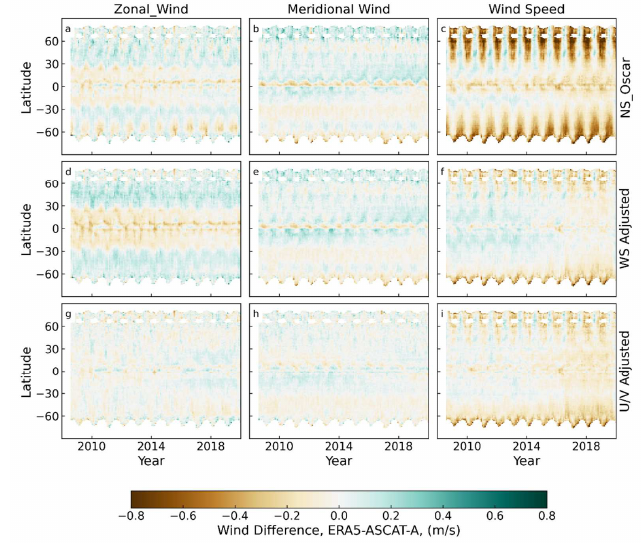
Figure A2. Months of monthly meridional wind adjustments applied to speed-adjusted ERA5 winds.